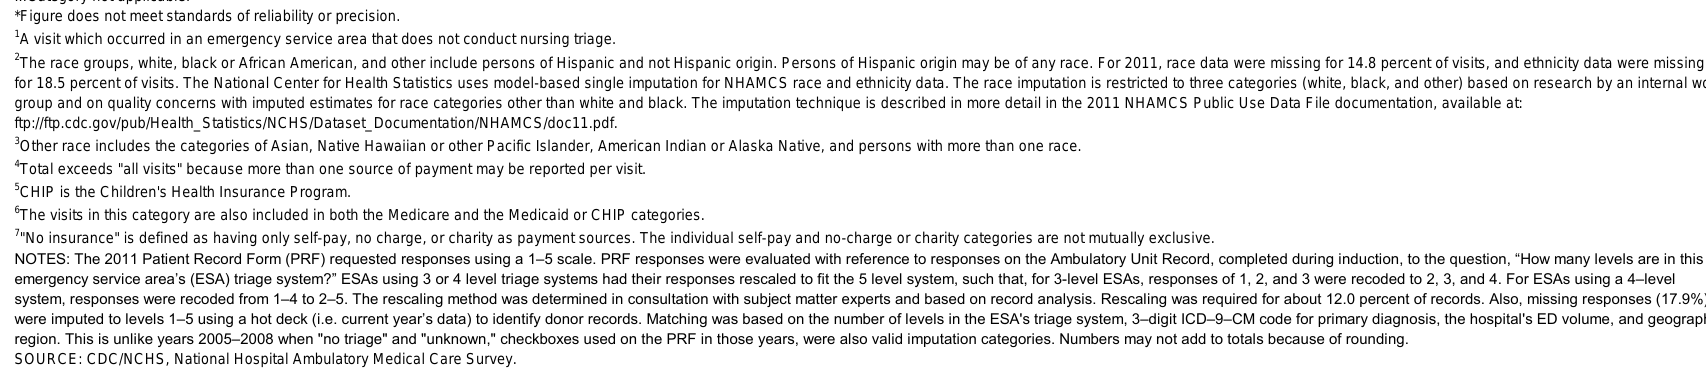
...Category not applicable. *Figure does not meet standards of reliability or precision. 1 A visit which occurred in an emergency service area that does not conduct nursing triage. 2 The race groups, white, black or African American, and other include persons of Hispanic and not Hispanic origin. Persons of Hispanic origin may be of any race. For 2011, race data were missing for 14.8 percent of visits, and ethnicity data were